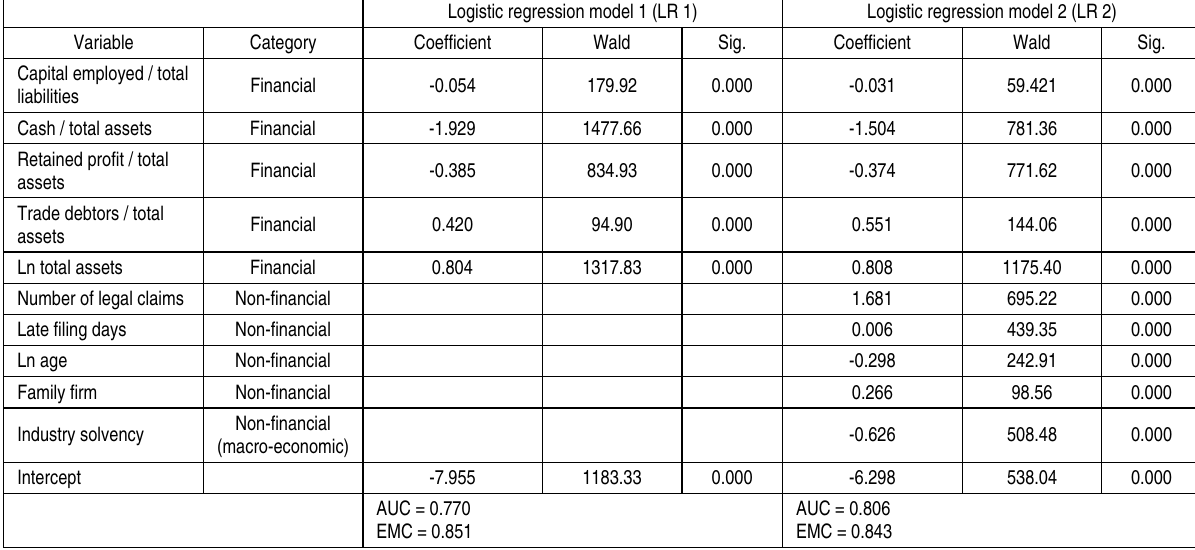
Table 3. Logistic-default prediction models for the